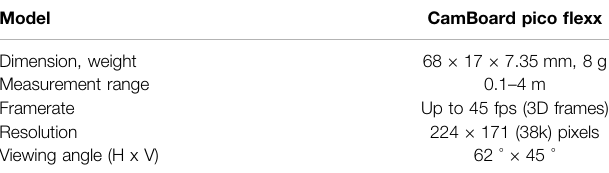
TABLE 3 | Time-of- fl ight sensor speci fi cations.